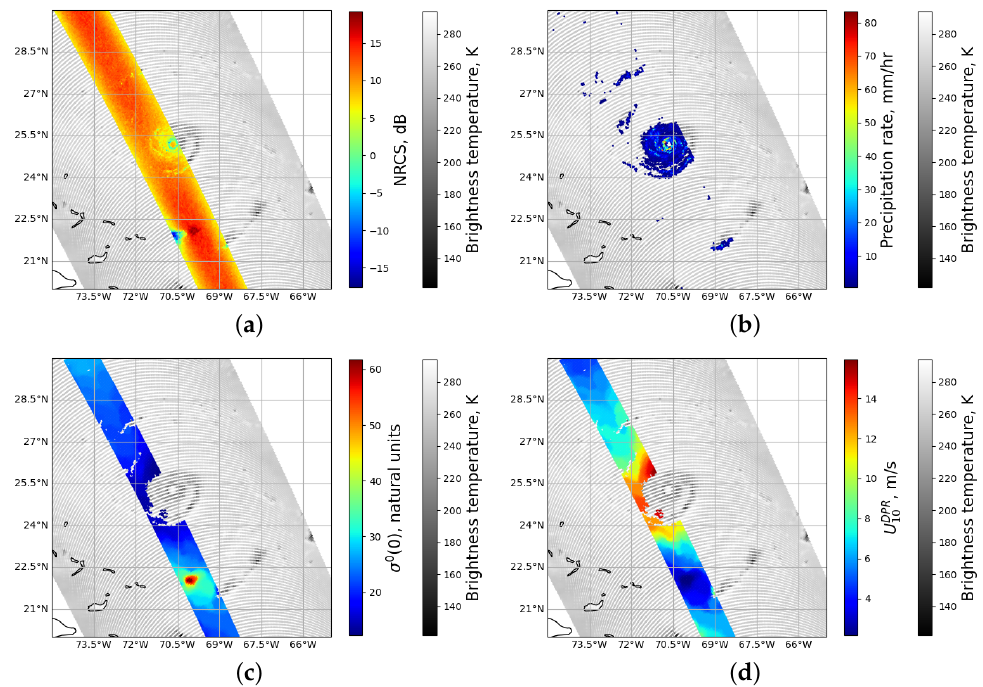
Figure 8. The DPR track over Hurricane Dorian at 21:33 UTC on 30August 2019. Raw data of Ku-band radar over the image of brightness temperature from the GMI data at 89 GHz, V-polarization ( a ); rain rate ( b ); “nadir NRCS” ( c ); wind speed ( d